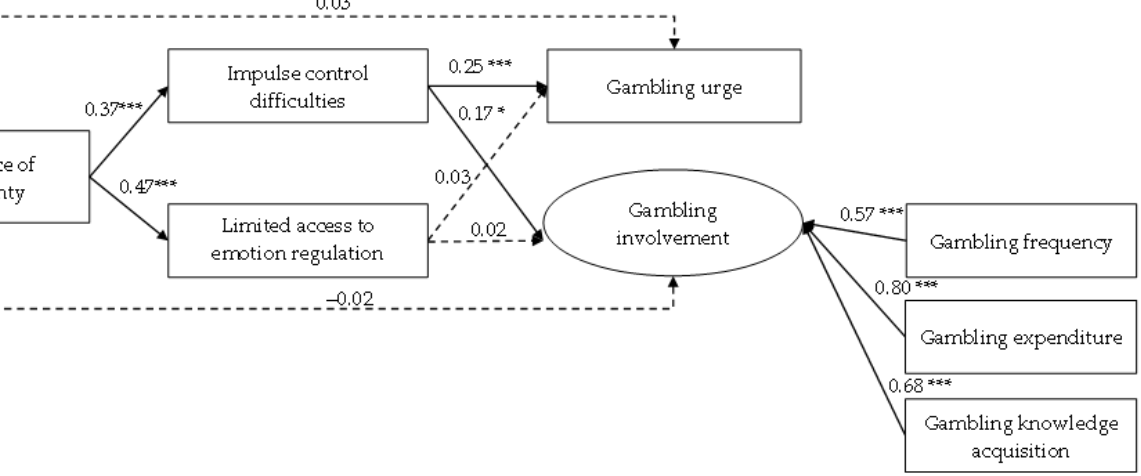
Figure 2. The final path model with standardized estimates. Note: * p < 0.05, *** p < 0.001. This model has controlled the effects of age and gender on gambling urge and gambling involvement, and the covariance of age and gender. Moreover, the error covariances between impulse control difficulties and limited access to emotion regulation strategies, as well as gambling urge and gambling involvement, were allowed and statistically significant ( p < 0.001).